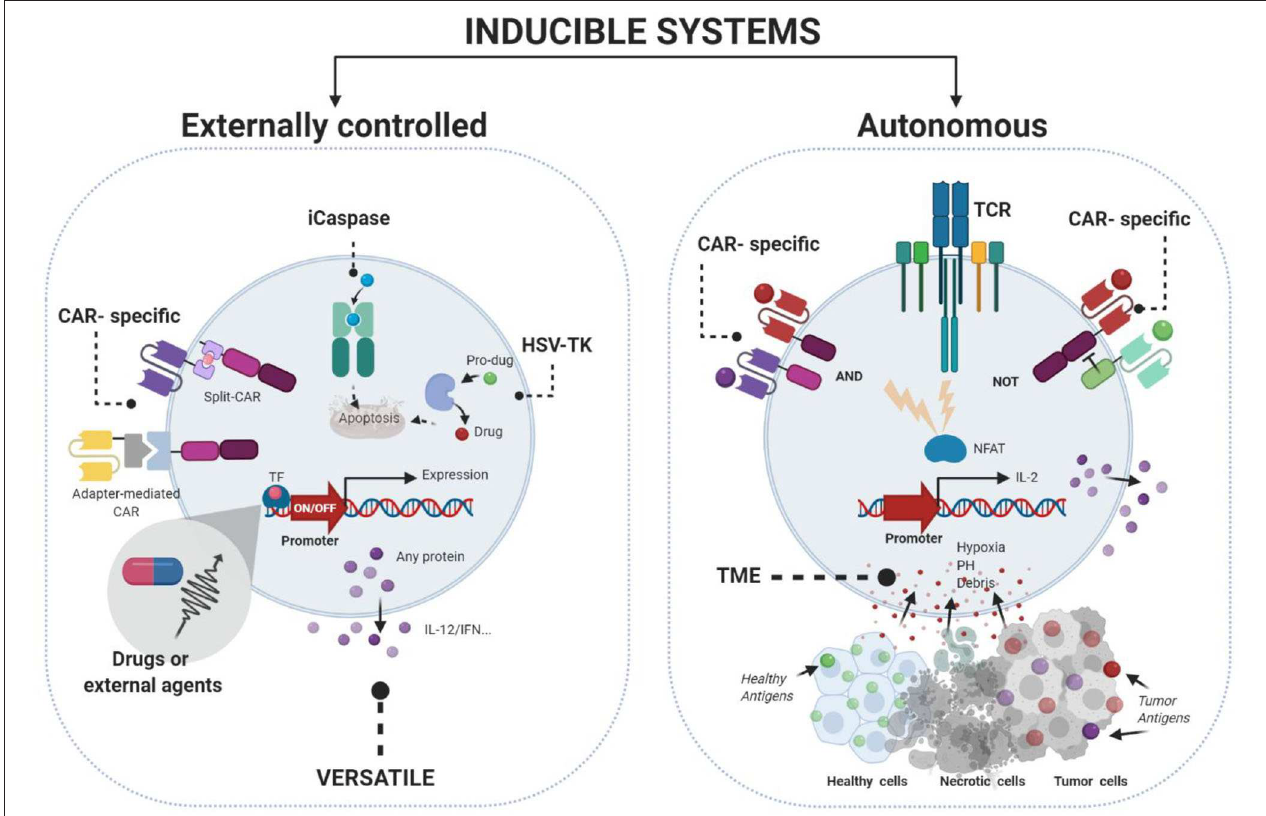
FIGURE 1 | Gene therapy strategies to control immunogene therapy using inducible systems. Externally controlled systems (left) require the addition of an external stimuli (chemical or physical) to modulate the expression of the desire transgene. Autonomous systems (right) are designed to control the expression of the transgene in function of different cellular situations such as inflammation, cytokines, hypoxia, or pH. Figures were created with BioRender.com.